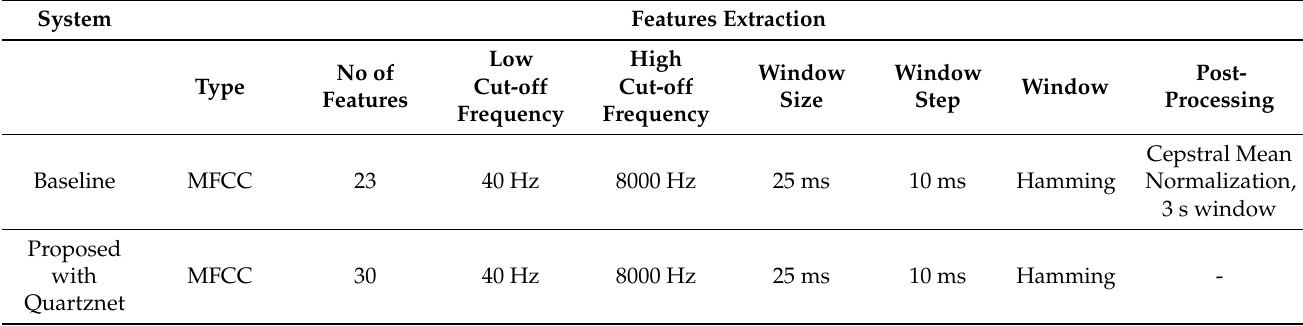
Table 6. Features extraction details for baseline and QuartzNet-based systems.